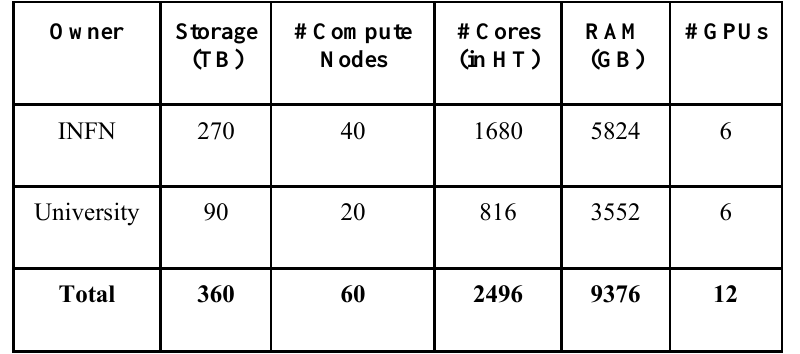
Table 1. Cloudveneto.it computing resources by